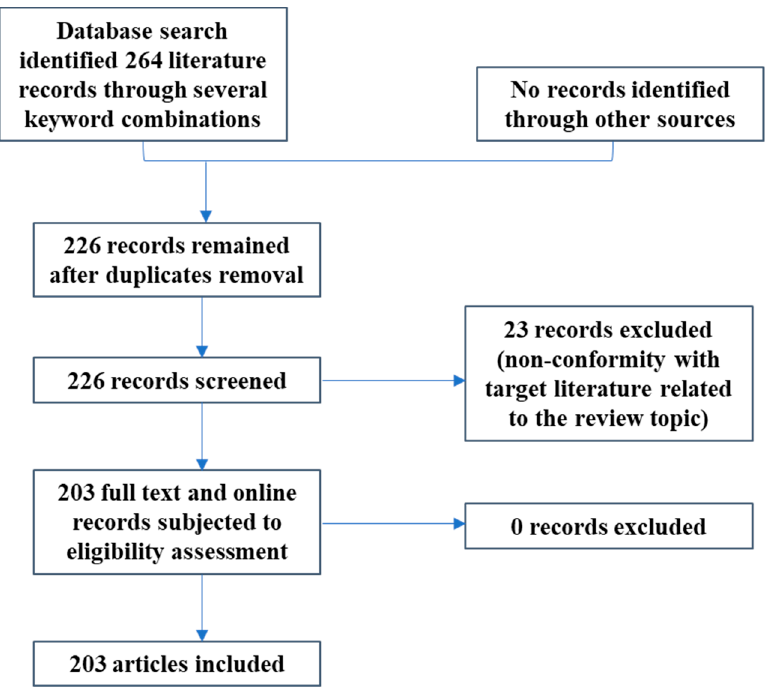
Figure 1. PRISMA flow chart depicting the total of recognized, screened, included and excluded materials for this review.